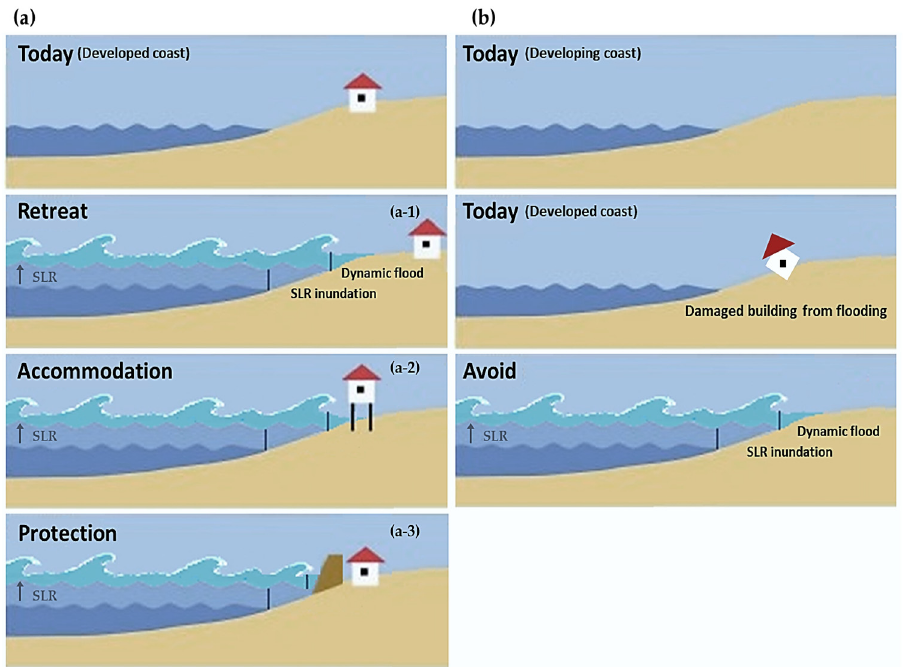
Figure 3. Coastal adaptation strategies concept including retreat ( a-1 ), accommodation ( a-2 ), protec- tion ( a-3 ), and avoid ( b ) to reduce sea-level rise impacts on developed coasts (Adapted from ref. [49], Dronkers, J.; Gilbert, J.; Butler, T.E.; Carey, L.W.; Campbell, J.J.; James, J.; McKenzie, E.; Misdorp, C.; Quin, R.; Ries, N.; et al. Strategies for Adaption to Sea Level Rise. Report of the IPCC Coastal